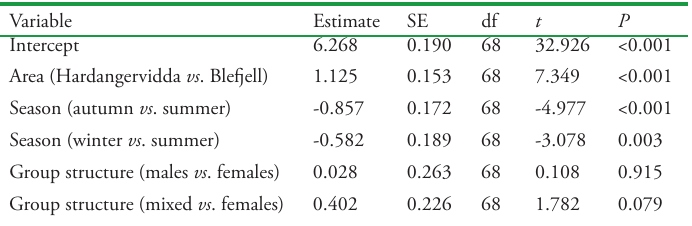
Table 5. Summary of the linear mixed-effects model for predicting escape distances (ln transformed) of reindeer groups disturbed by an intruding person in Hardangervidda and Blefjell, south central Norway